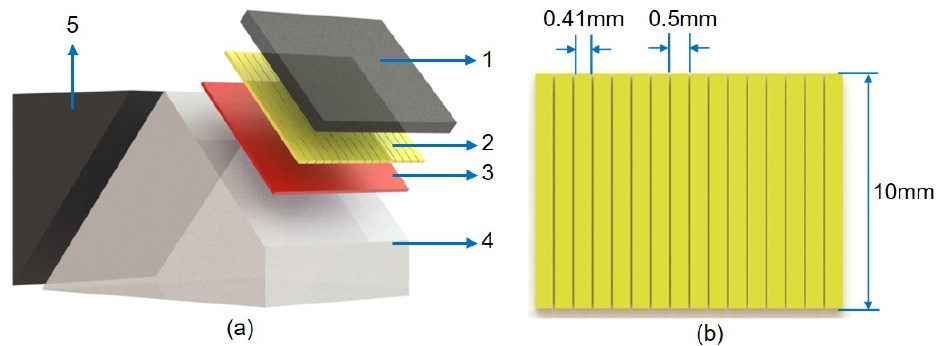
Figure 1. Structural design of 16-channel PMUT linear array probe: ( a ) exploded view, 1-backing damping block, 2-piezoelectric film linear array, 3-acoutic impedance matching layer, 4-wedge block, 5-sound absorbing block, ( b ) geometry of the piezoelectric film linear array.